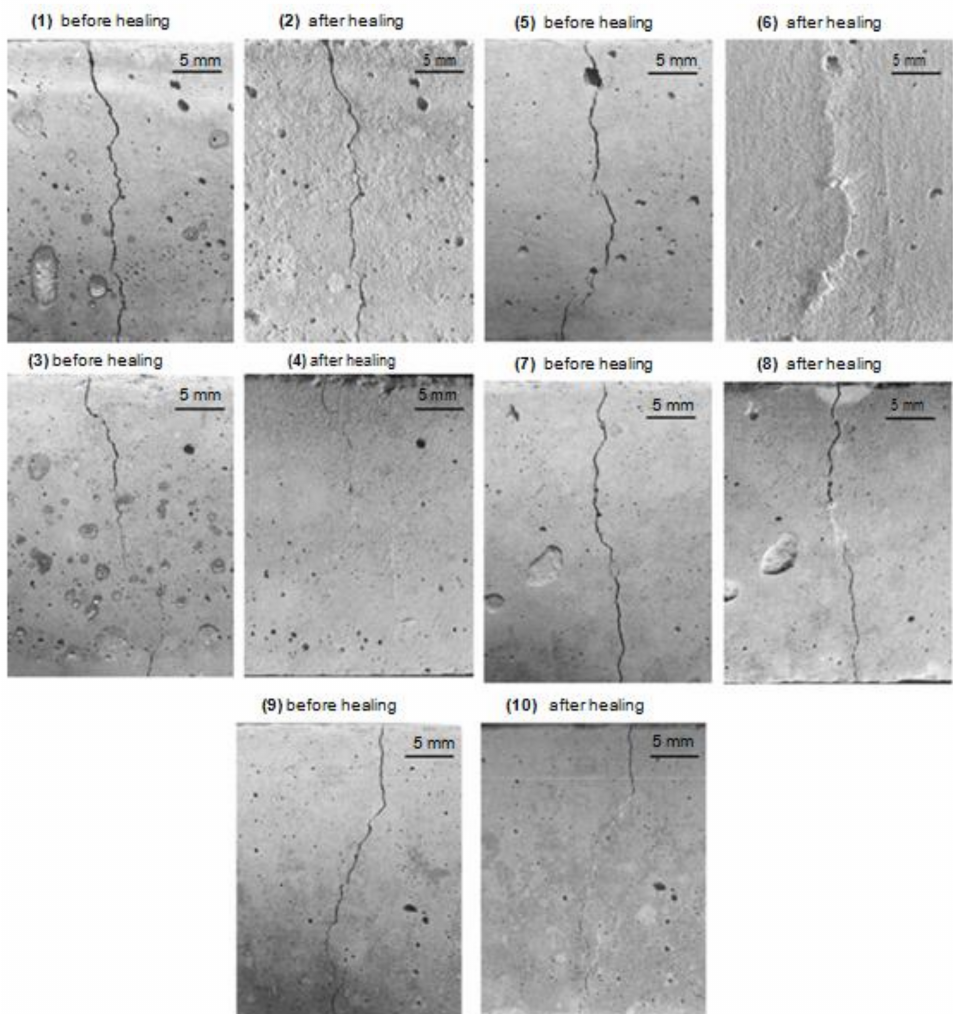
Figure 4. Images of crack healing process (Adapted with permission from Elsevier